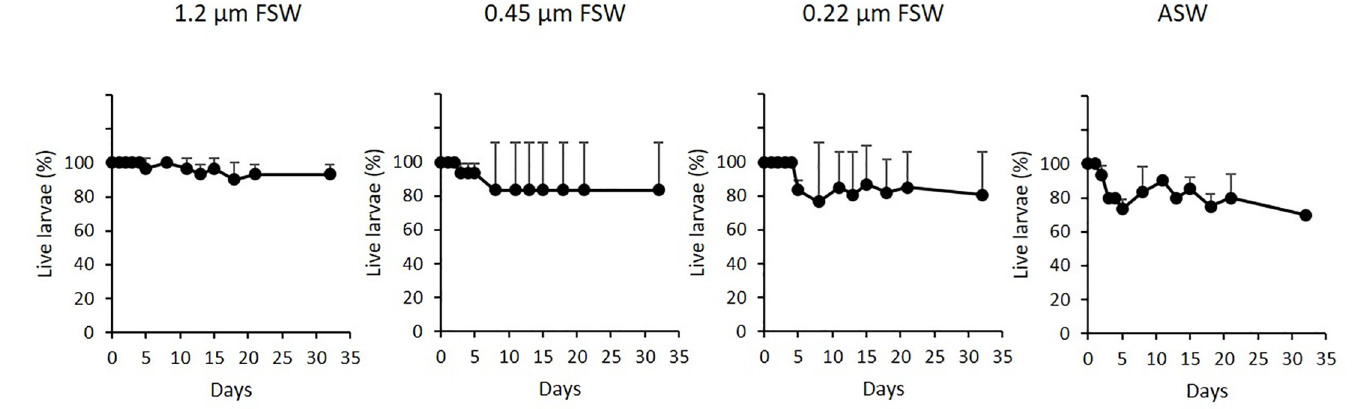
Fig 2. Average number of live planulae of Rhytisma fulvum fulvum over time in cultures maintained with different levels of filtered seawater (FSW) and autoclaved seawater (ASW). Cultures were maintained with water exchange of 50% of the volume of the cultures on alternative and under light:dark cycles (12:12 hours). The experiment was performed with planulae harvested in 2015. Data are shown as means ± S.D, (n = 3, 10 planulae per